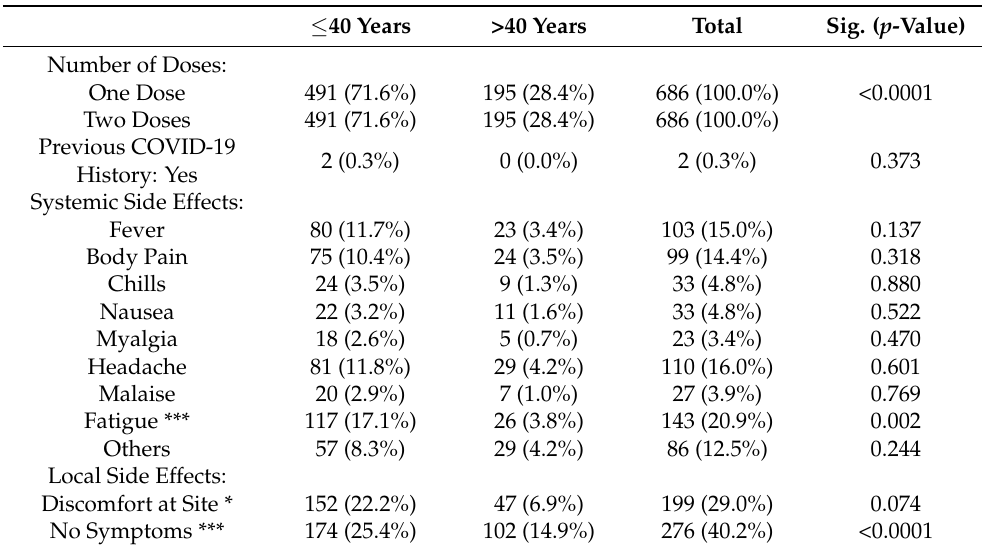
Table 3. Prevalence of systemic and local side effects for ChAdOx1 n-COV-19 vaccine among older and younger